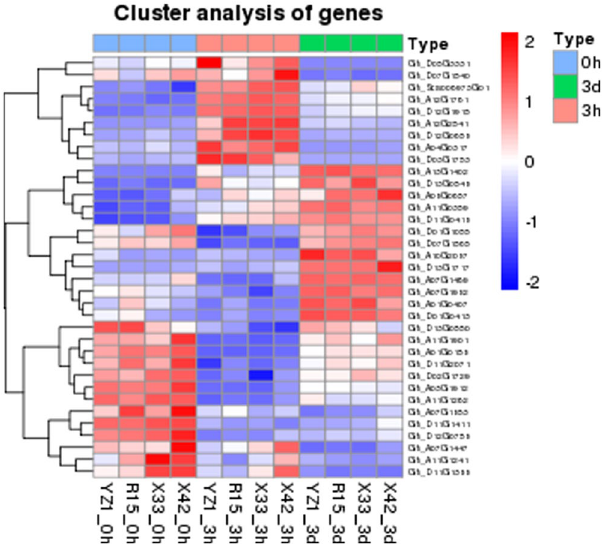
Figure 5. Heatmap of SE-related functional genes (P-value < 0.05, |log2FoldChange| > 2 at one sampling point).